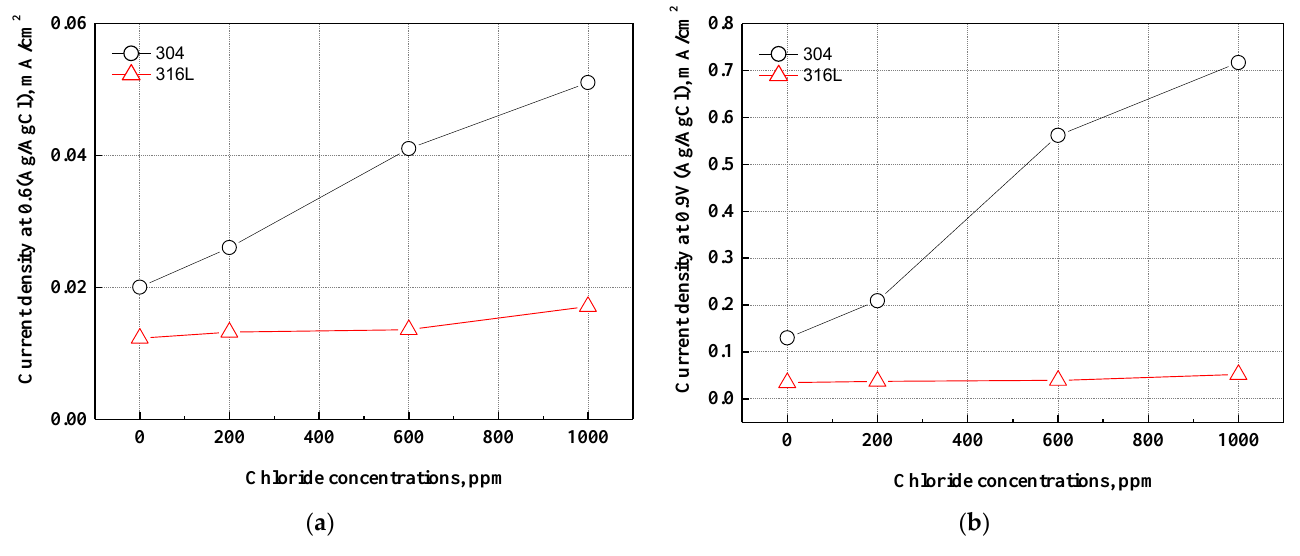
Figure 5. Comparison of current density at the various operating voltages for 304 and 316L stainless steels after a potentiodynamic polarization experiment: ( a ) normal operating voltage (0.6 V, Ag/AgCl); ( b ) deteriorative operating voltage (0.9 V, Ag/AgCl).